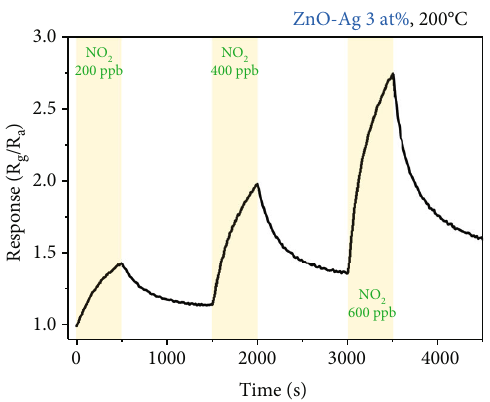
Figure 8: Response curves of the 3 at% Ag-functionalized porous ZnO sheets with 200, 400, and 600ppb NO 200 °